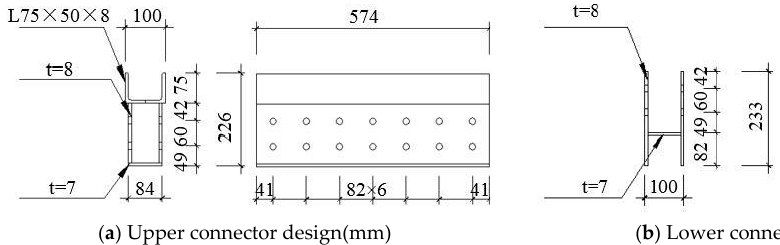
Figure 1. Dimension and rebars of specimens.